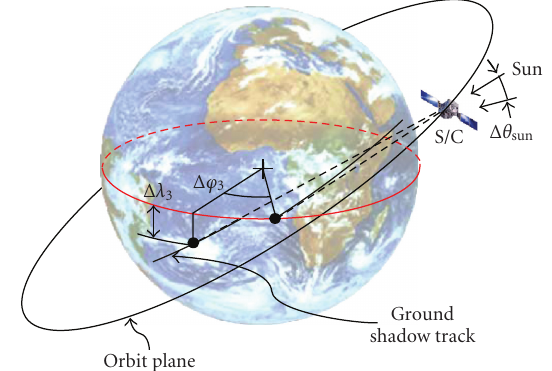
Figure 10: The e ff ect of Earth rotation around the Sun on the ground shadow